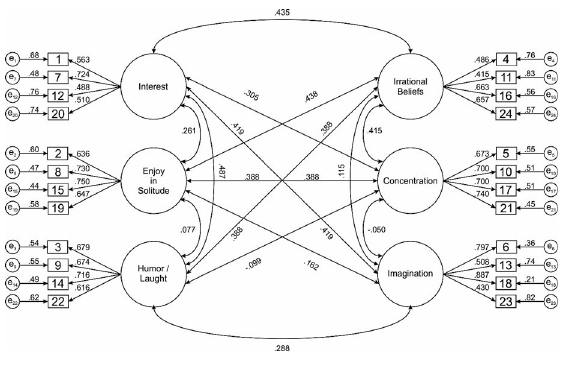
Fig 1. GSAM 6-factor related